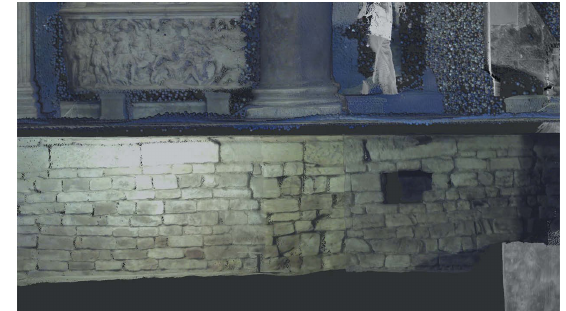
Figure 1. Illustrations of different numerical modeling levels. A) Masonry wall, B) Macro modeling, C) Simplified micro